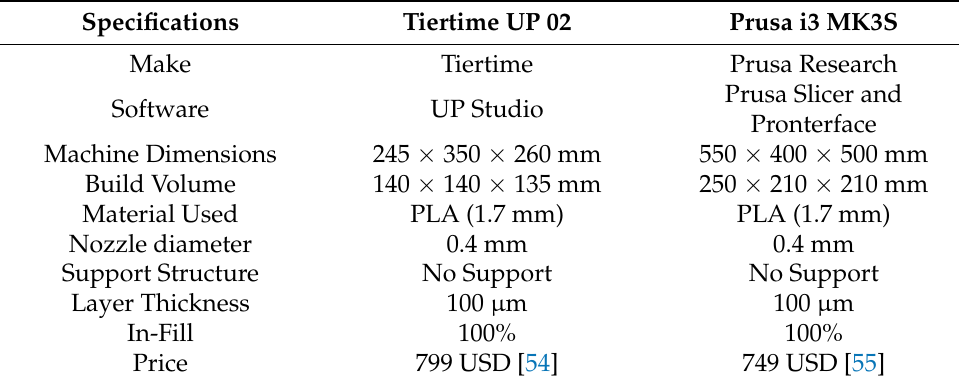
Table 2. Printer specifications and selected